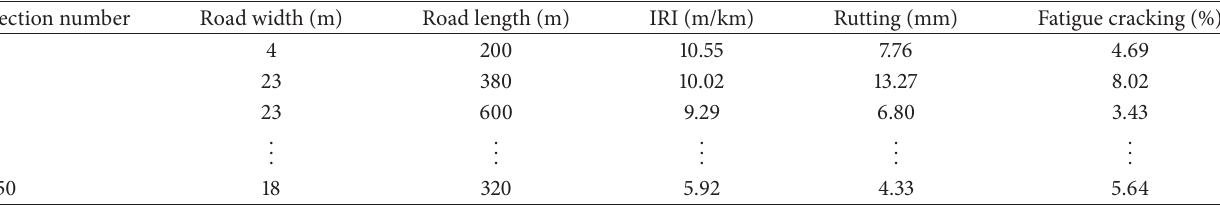
Table 2: Setup of the measured field data used for the heuristic permutation